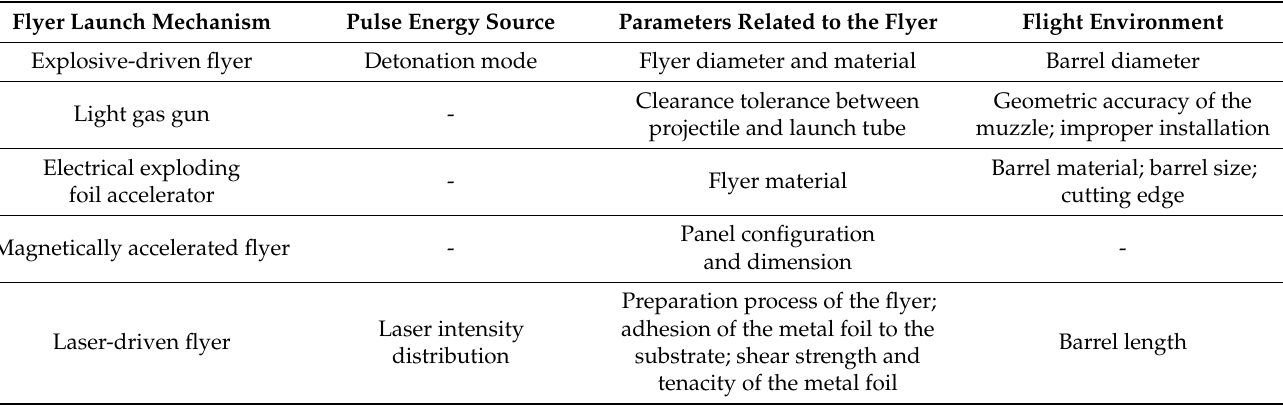
Table 5. Influence factors of flyer morphology mentioned in the